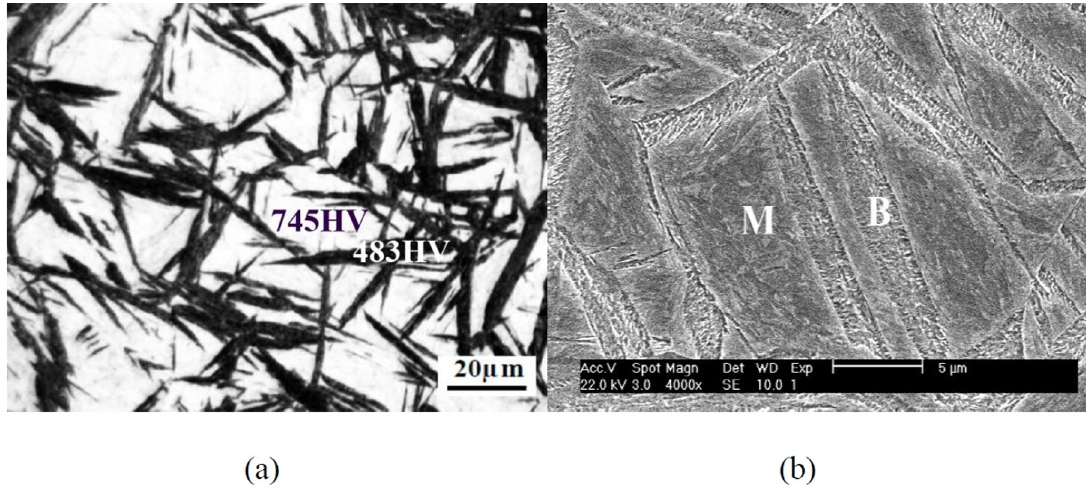
Figure 1. The lower bainite - martensite mixed microstructure, austenitized at 910°C (a) optical and (b) Scanning electron (SEM)